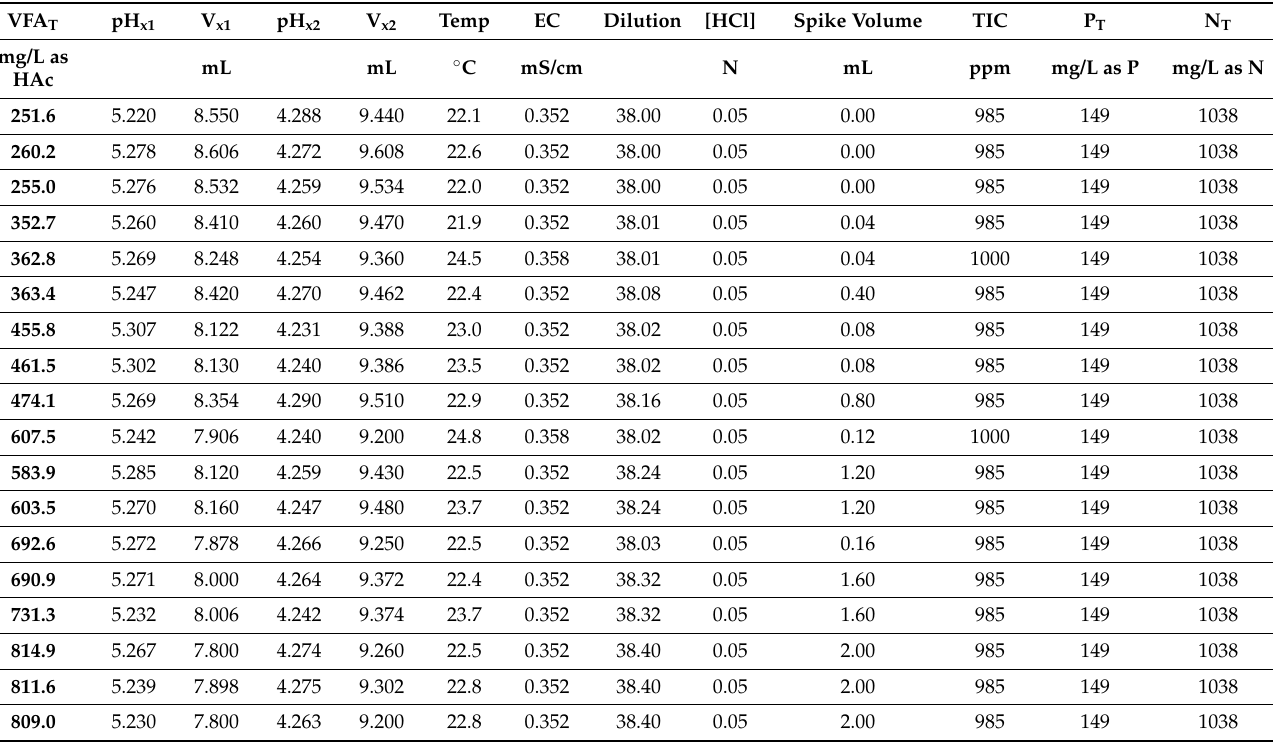
Table A1. Results of Shafdan VFA T + spiking.